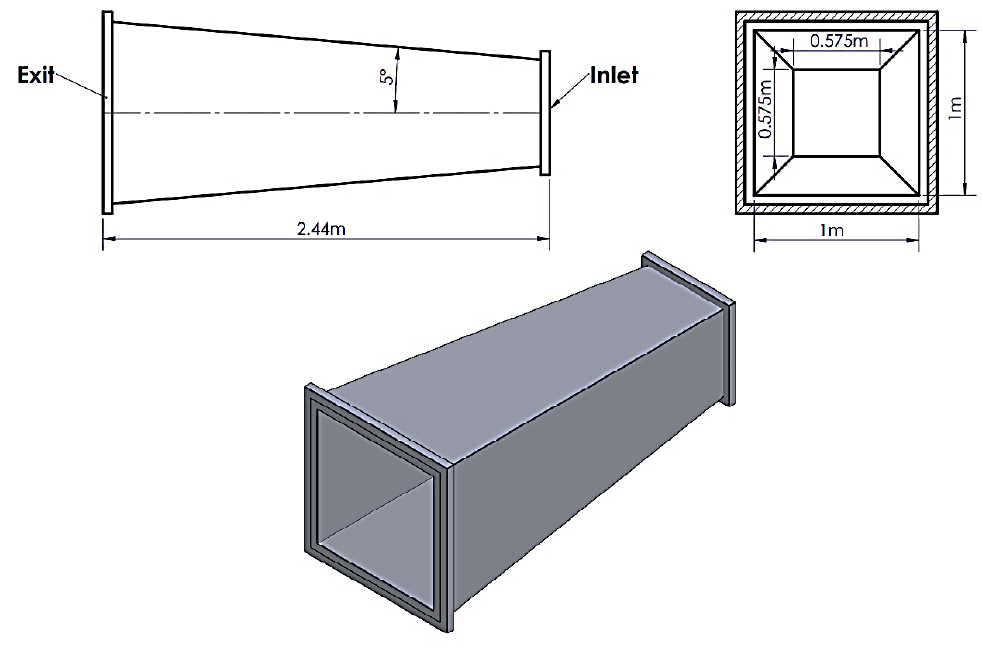
Figure 7. The 3-D model of the diffuser.